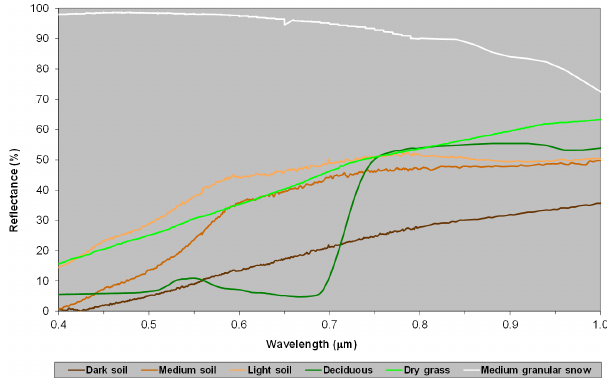
Figure 6. Spectral albedos of common Earth cover types from the ASTER database.